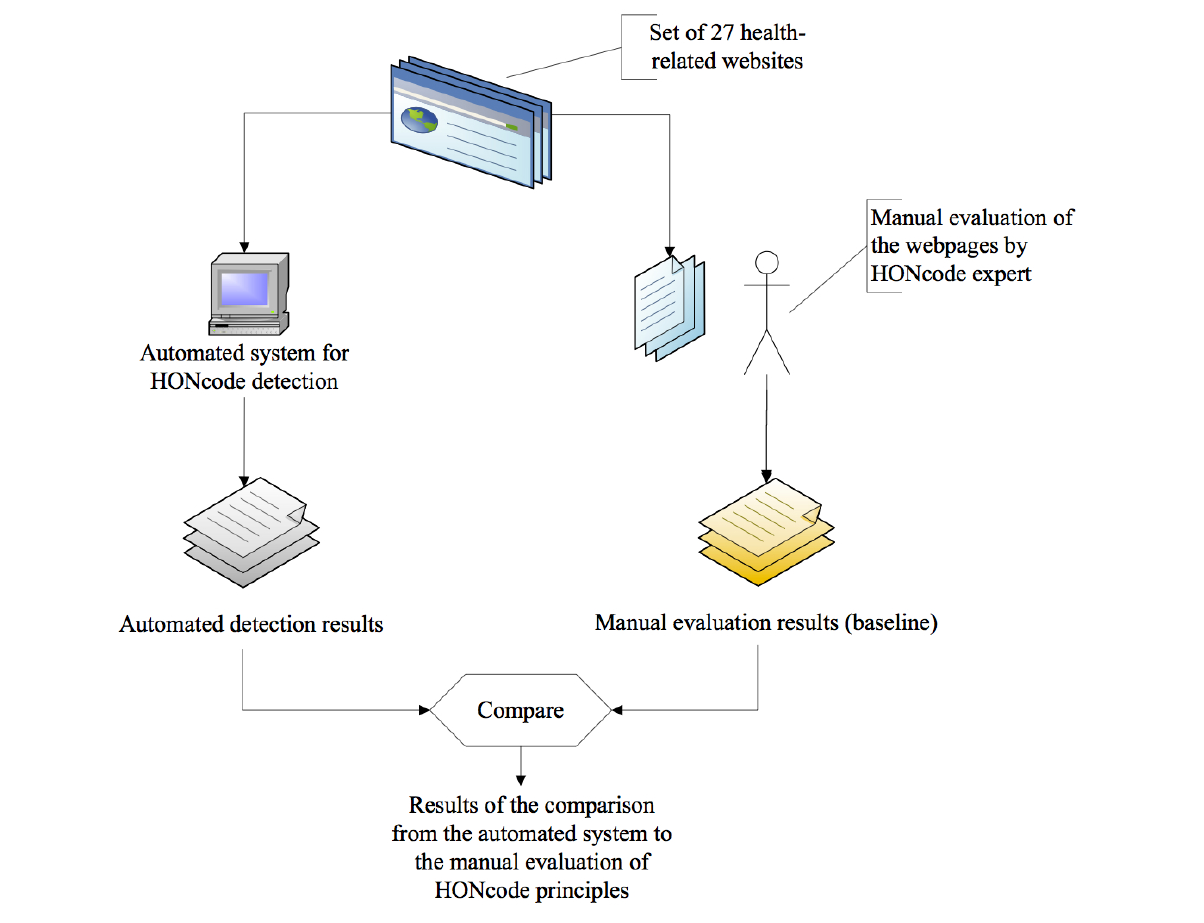
Figure 2. Comparison of the automated HONcode detection evaluation to manual